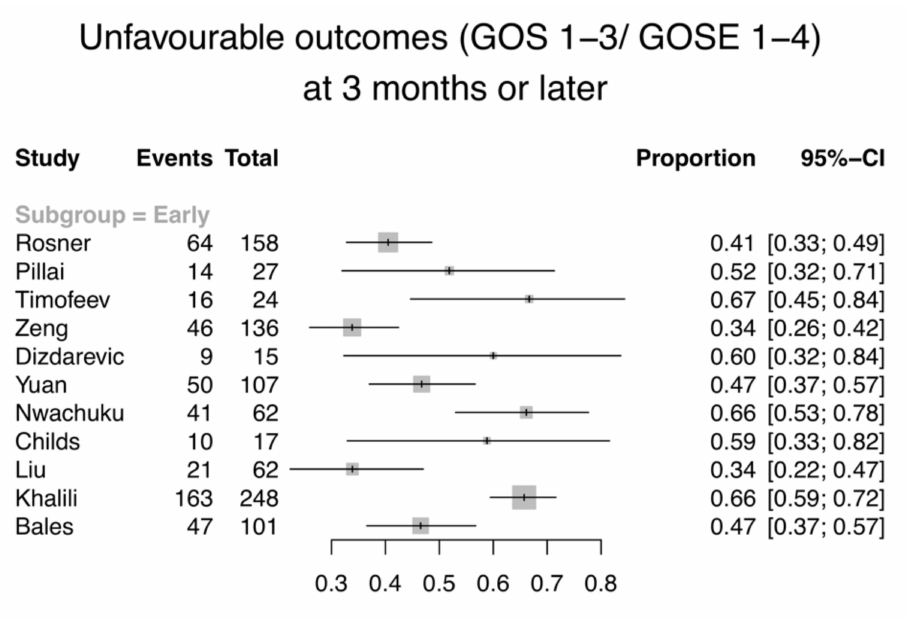
Figure 3. Forest plot illustrating the proportion and 95% CI of unfavourable outcomes, defined by Glasgow Outcome Scale (GOS) 1-3 or the extended Glasgow Outcome Scale (GOS-E) 1-4 at 3 months or later for individual studies. All studies are in the early EVD group. (Studies in the late EVD group did not report unfavourable outcomes at 3 months or